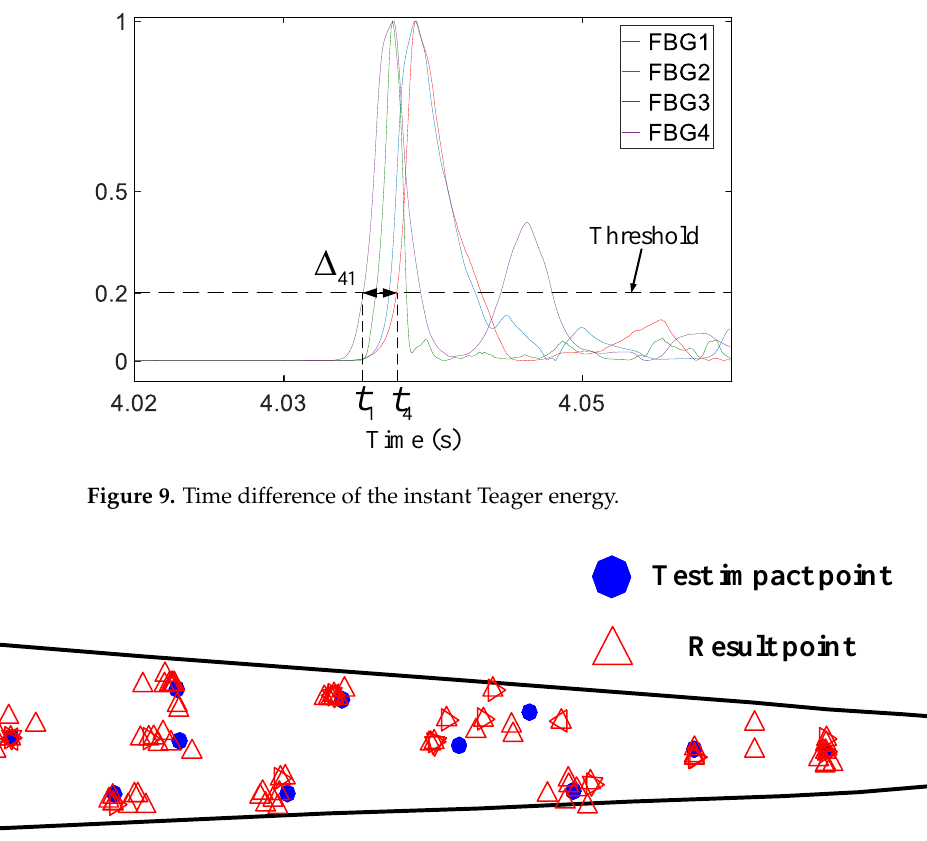
Figure 11. The mean absolute error at the impact points.